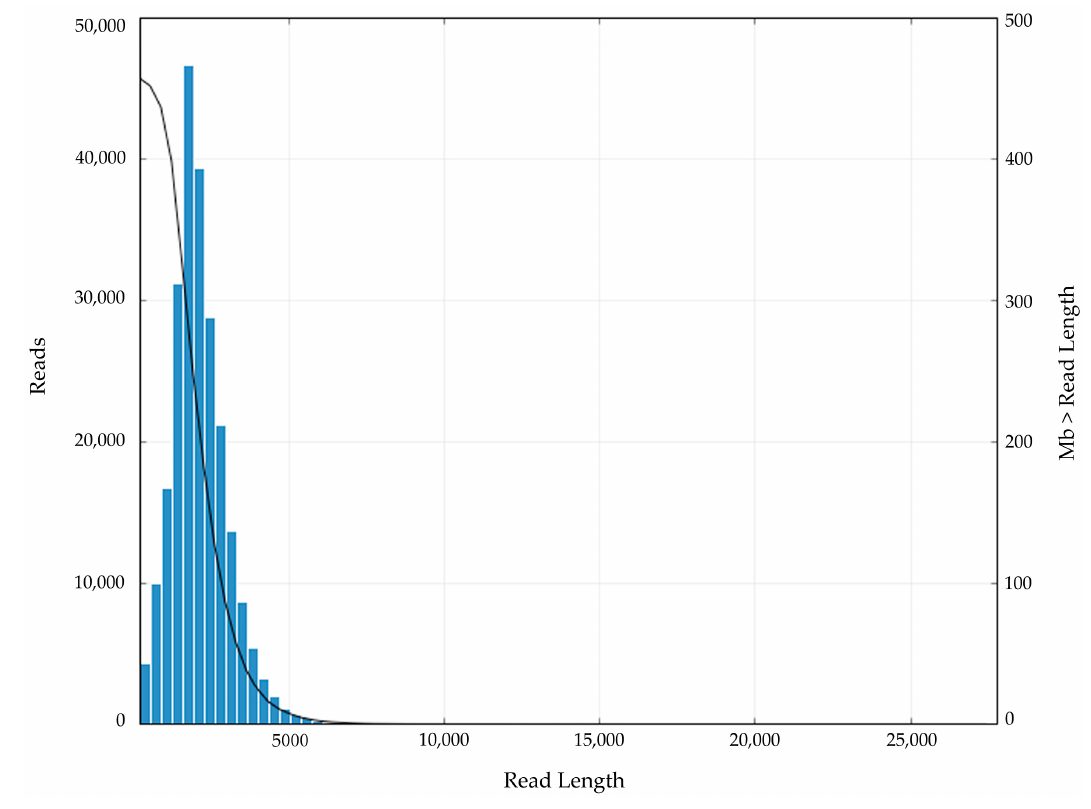
Figure 1. Distribution of the number and length of raw reads.